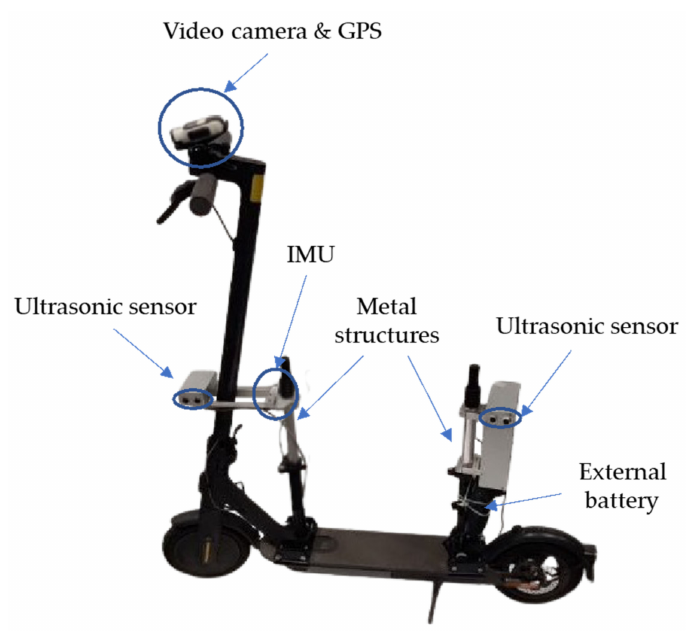
Figure 7. Instrumented